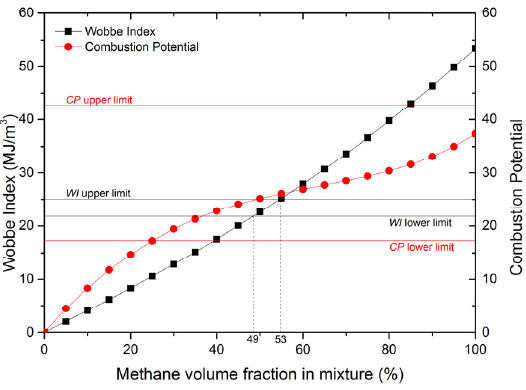
Figure 1. Possible methane ratio range of LNG with air for biogas substitution.